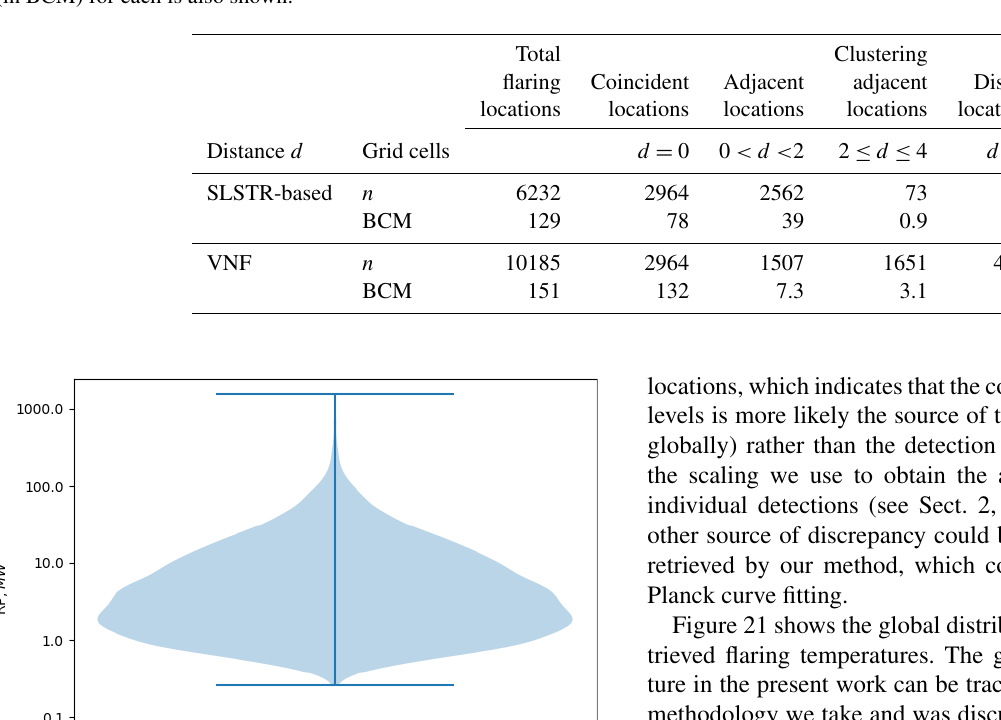
Table 2. Comparison between the number ( n ) of flaring locations by VNF and the SLSTR-based method: total number, coincident, adjacent ( < 2 grid cells away), clustering adjacent ( ≥ 2 and ≤ 4 grid cells away), and distant ( ≤ 4 grid cells away) locations. The sum of the activity (in BCM) for each is also shown.